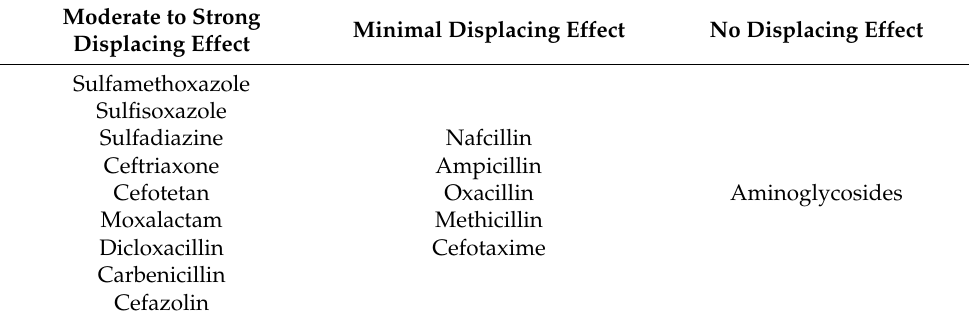
Table 6. Antibacterials with different bilirubin displacing activity (Reprinted with permission from [175] Copyright year, 2023; Copyright owner,